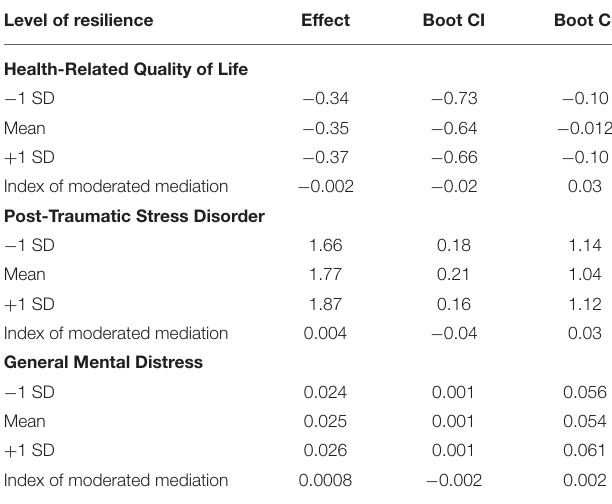
TABLE 4 | Conditional indirect effects of PTEs on HRQoL, PTSD, and general mental